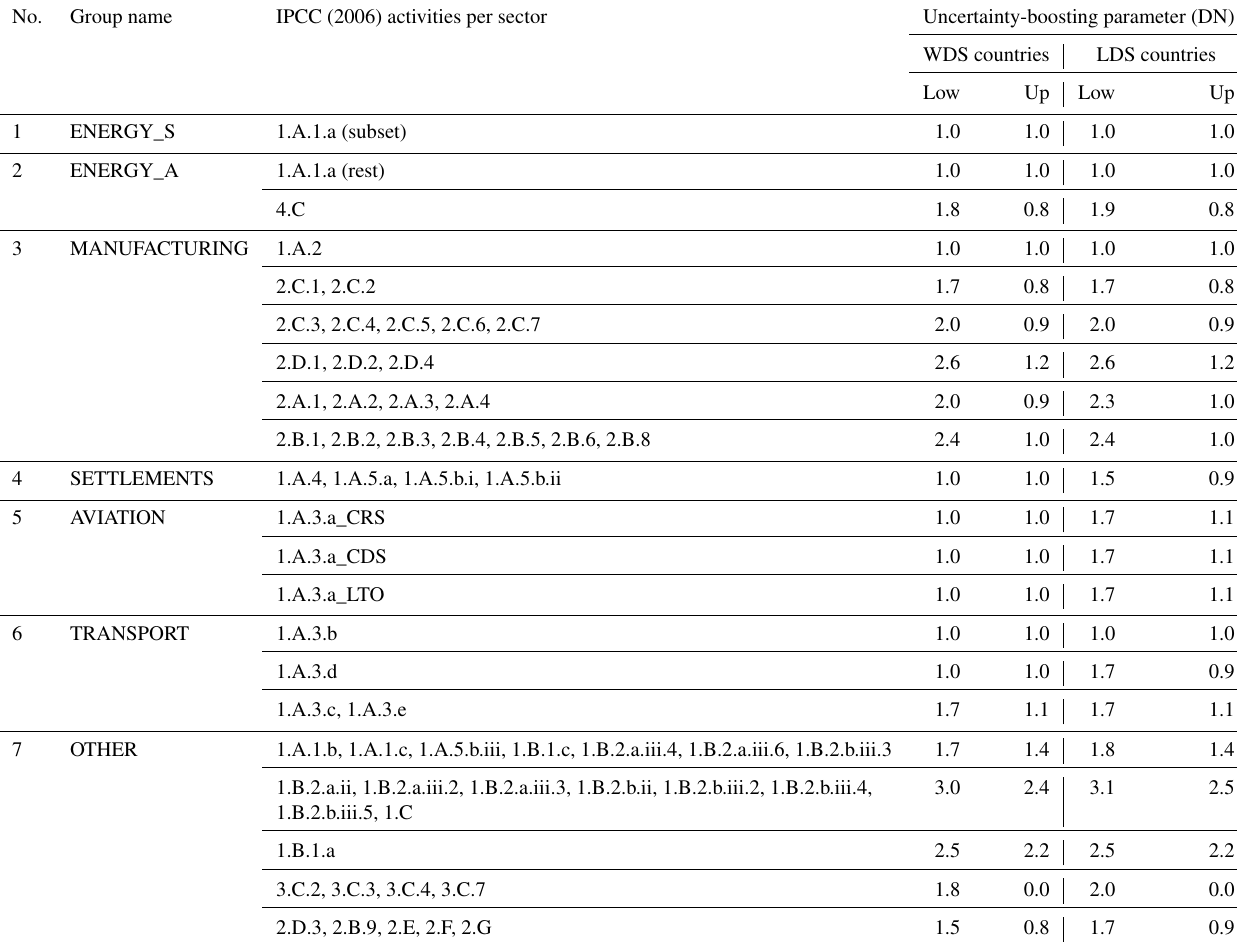
Table 8. Dimensionless (DN) lower- and upper-half-range boosting parameter for countries with well- and less well-developed statistical infrastructures – WDSs and LDSs,